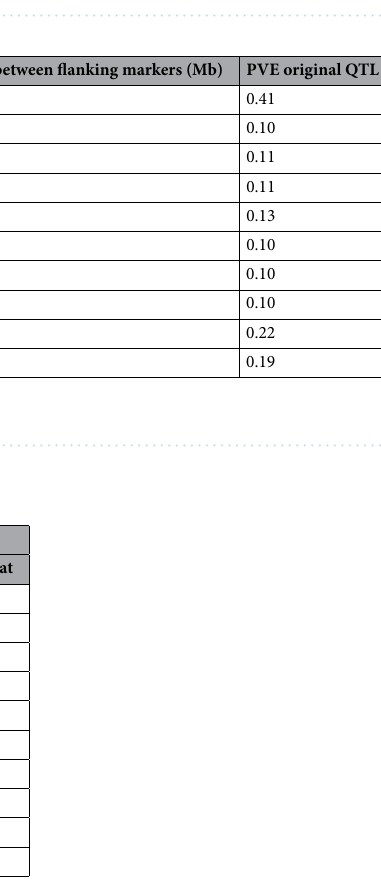
Table 3. Characterization of MQTL.